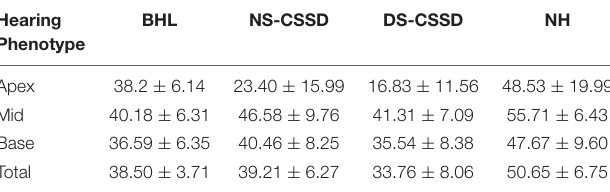
TABLE 4 | The ganglion cell counting number of each hearing phenotype at P30.